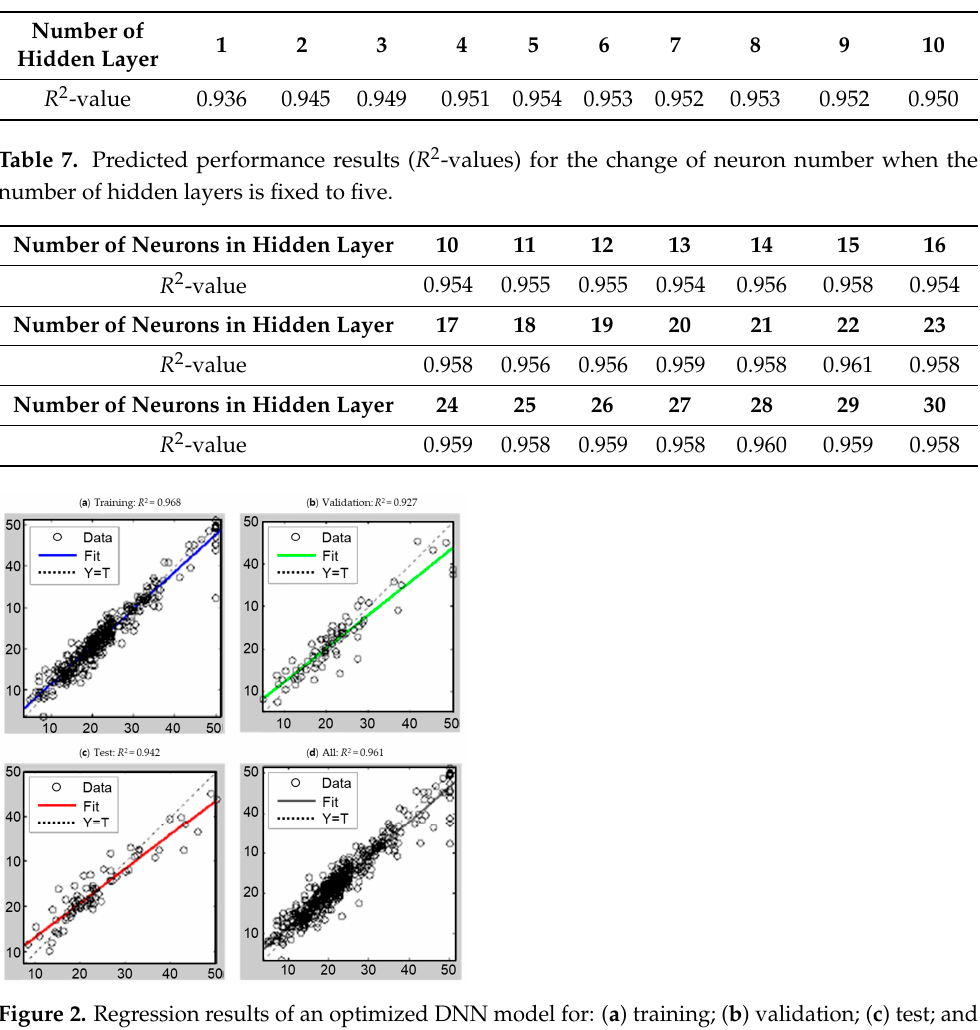
Table 6. Predict performance results ( R 2 -values) for the change of hidden layer number when the number of neurons is fixed to 10.